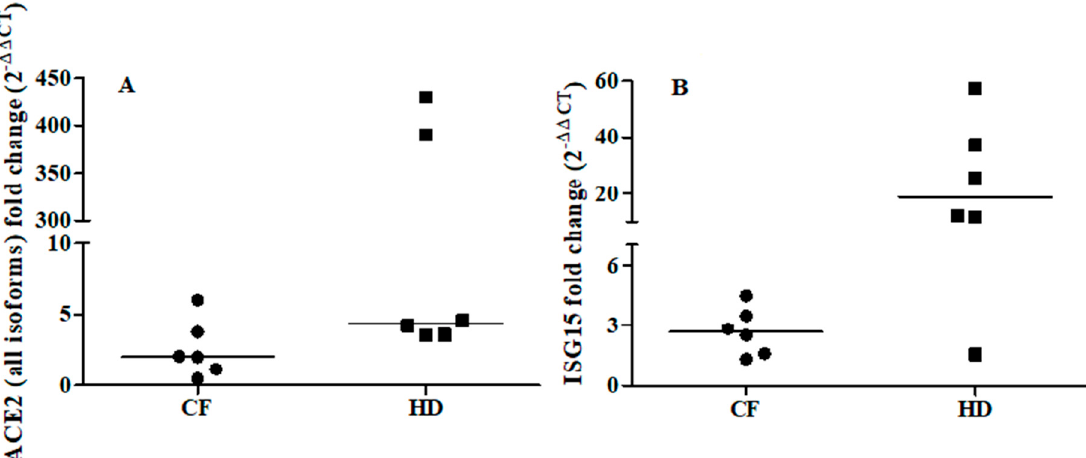
Figure 1. Fold change of ACE2 (all isoforms, Panel A) and ISG15 (Panel B) after ex vivo IFN β stimulation of the oropharyngeal cells of cystic fibrosis (CF) patients ( n = 6) and matched healthy controls (HD) patients ( n = 6). ACE2 and ISG15 expressions were examined before (T0) and after (T1) IFN β stimulation (5 ng/mL) for 24 h. ACE2: CF individuals, T0 vs T1 p = 0.116; HD individuals, T0 vs T1 p = 0.028 by Wilcoxon signed-rank test. ISG15: CF individuals, T0 vs T1 p = 0.030; HD individuals, T0 vs T1 p = 0.027 by Wilcoxon signed-rank test.